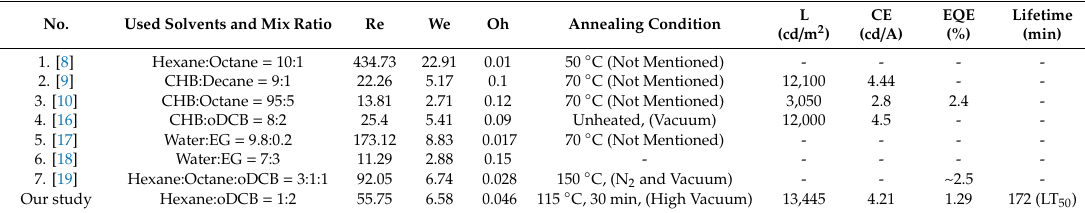
Figure 1. Ohnesorge map of the cosolvent QD inks used in previously studies and our study. For printable fluids region, which are green areas in the center of the graph, the ink is determined to have stable ink-jetting properties if there is dot in this area. Each dot with numbers on the Ohnesorge map represents the cosolvents QD inks from Table 1. Table 1. List of the solution properties of cosolvents’ QD inks and the device characteristics in previously reported researches (EG: ethylene glycol, L: luminance, CE: current efficiency, EQE: external quantum efficiency).